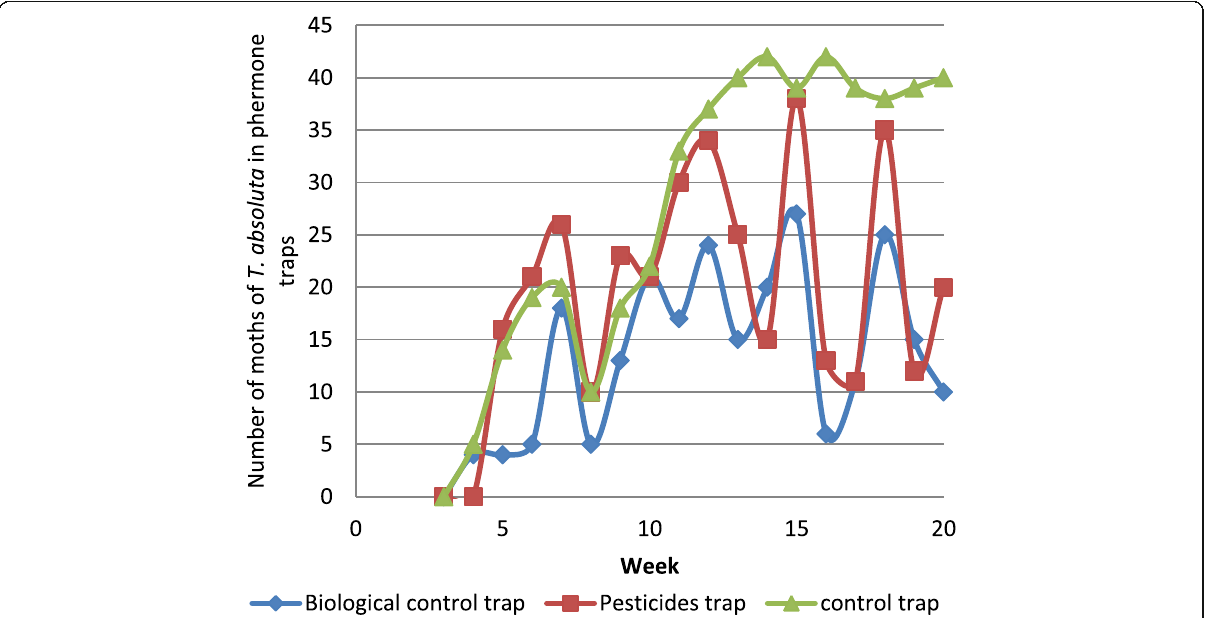
Fig. 1 Number of male moths of Tuta absoluta in pheromone traps in tomato greenhouses in the winter plantation, 2018 –